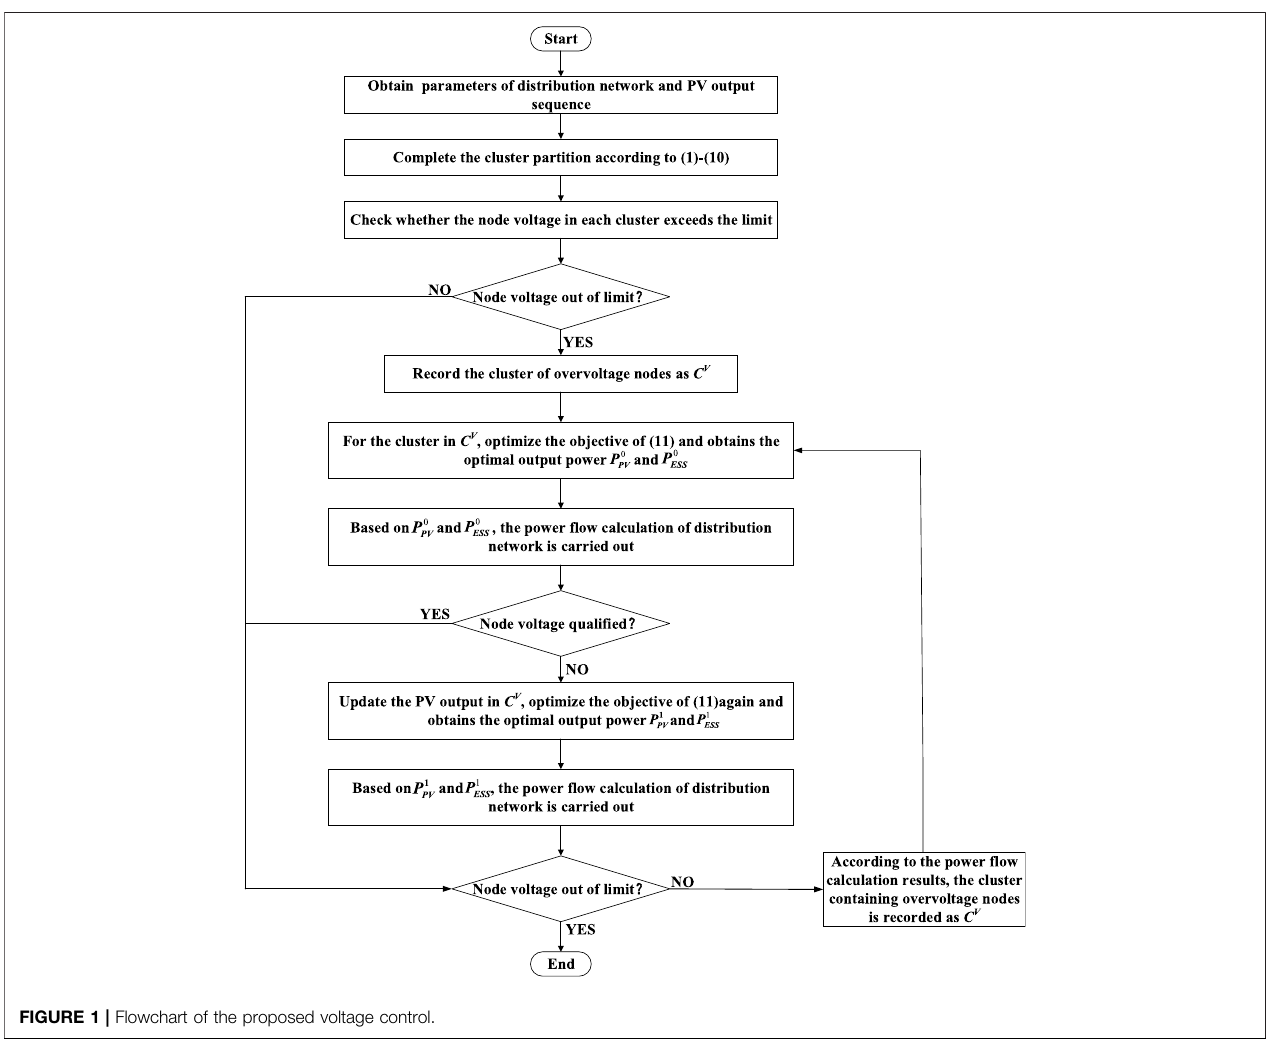
FIGURE 1 | Flowchart of the proposed voltage control.